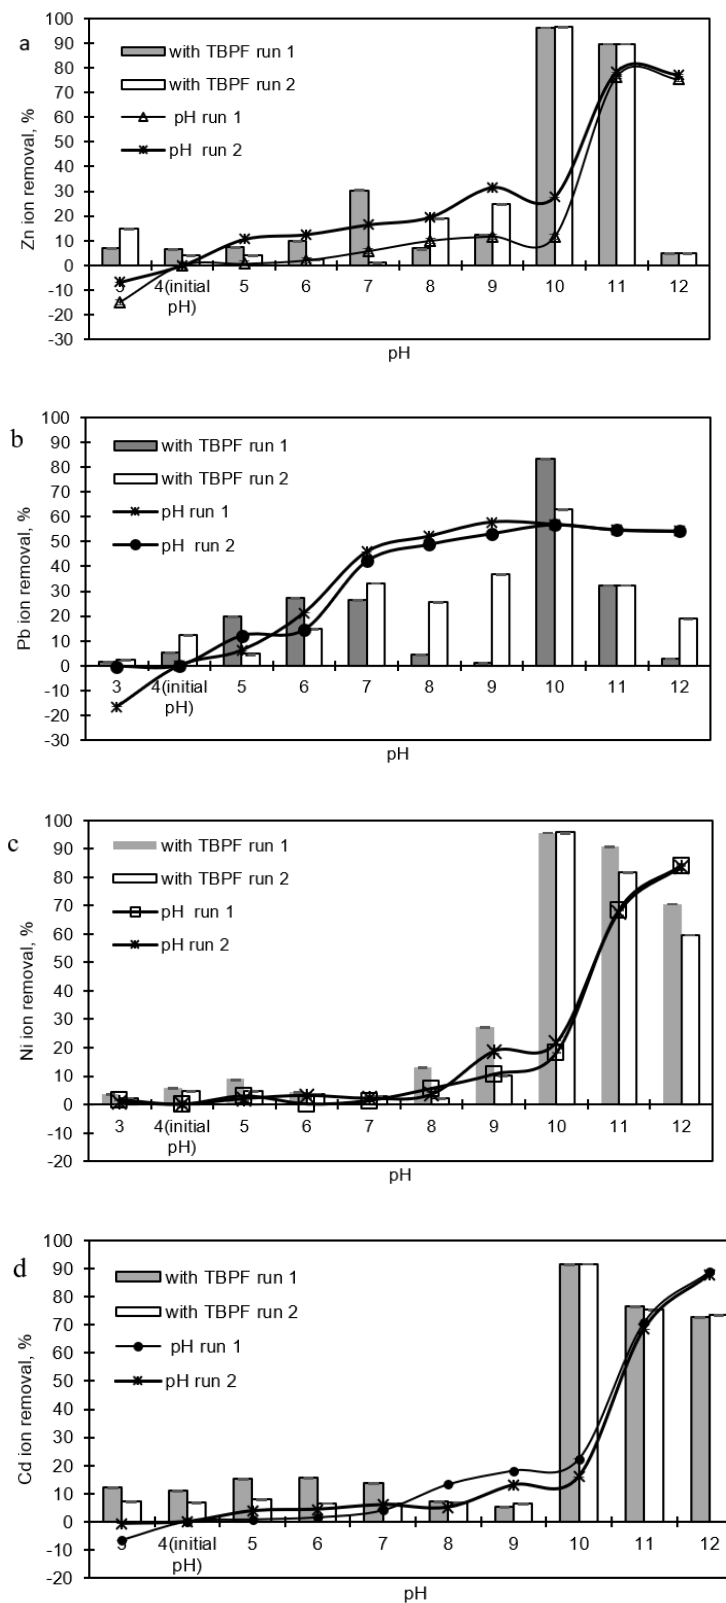
Figure 1. Effect of pH on metal ion removal: ( a ) Zn, ( b ) Pb, ( c ) Ni, and ( d ) Cd at a concentration of 2.0 mg/L.